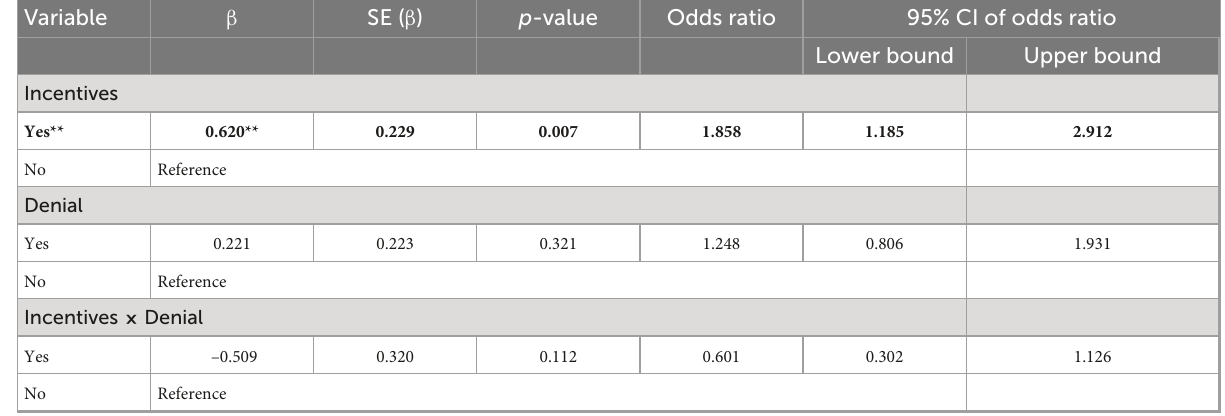
TABLE 2 Results of the multilevel ordered logistic regression